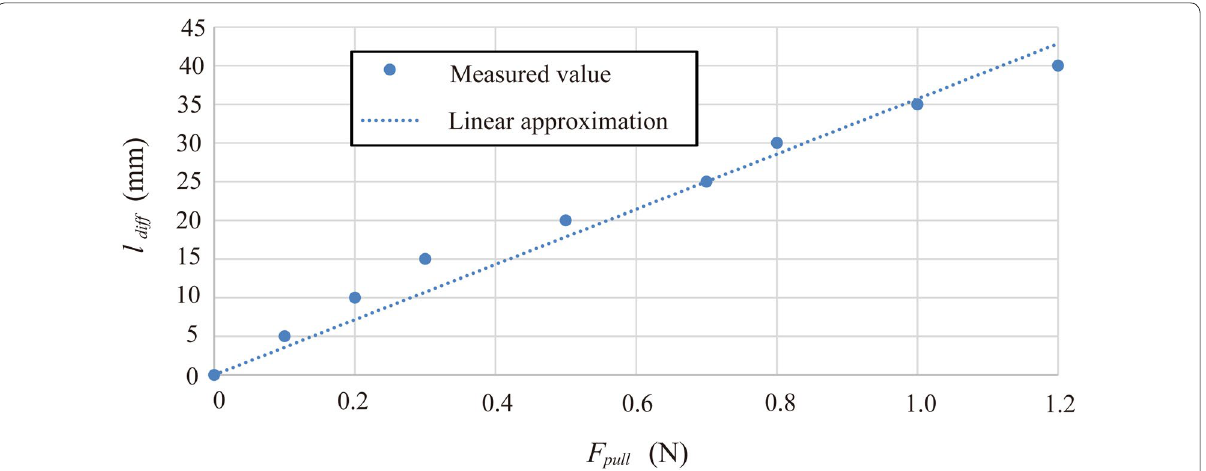
Fig. 40 Experimental results of load and stretch length of bellows pneumatic actuator with ring member inside